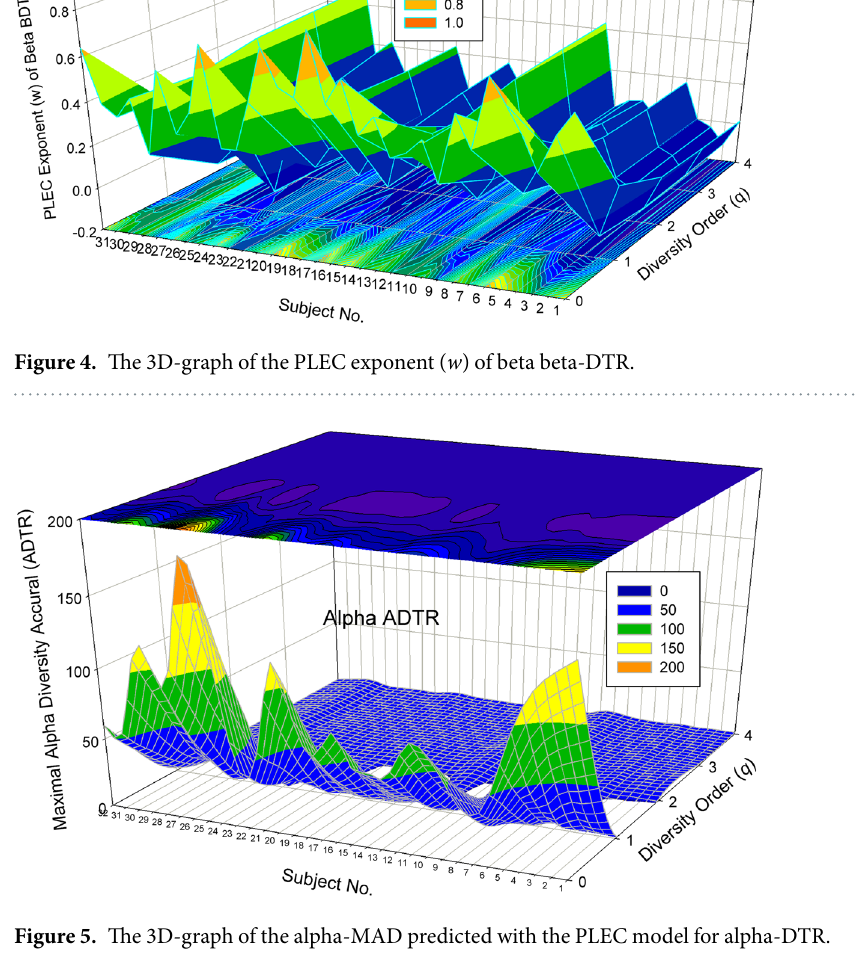
Figure 5. The 3D-graph of the alpha-MAD predicted with the PLEC model for alpha-DTR.